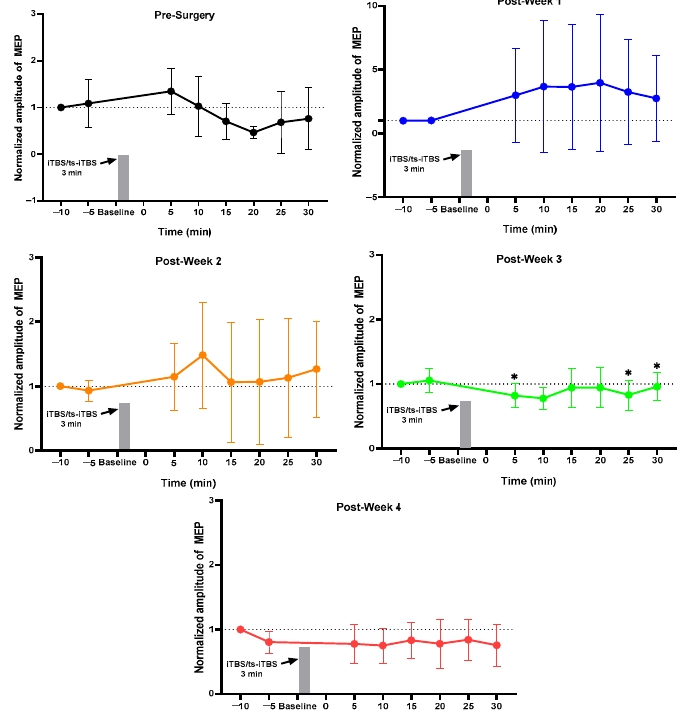
Figure 4. iTBS/ts ‐ iTBS ( n = 4). iTBS/ts ‐ iTBS (3 min). The level of significance was set to p < 0.050 *. Figure 4. iTBS/ts-iTBS ( n = 4). iTBS/ts-iTBS (3 min). The level of significance was set to p < 0.050 *.